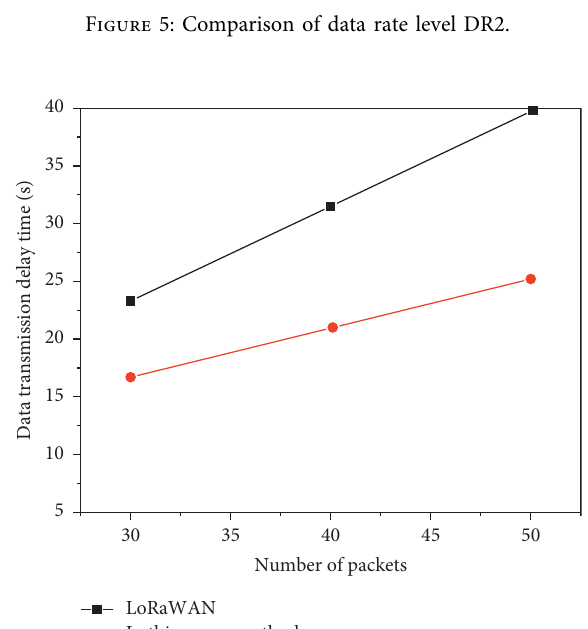
Figure 5: Comparison of data rate level DR2.